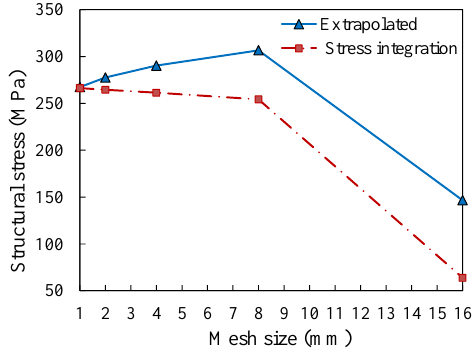
Figure 7. Variation of structural stress with mesh size.